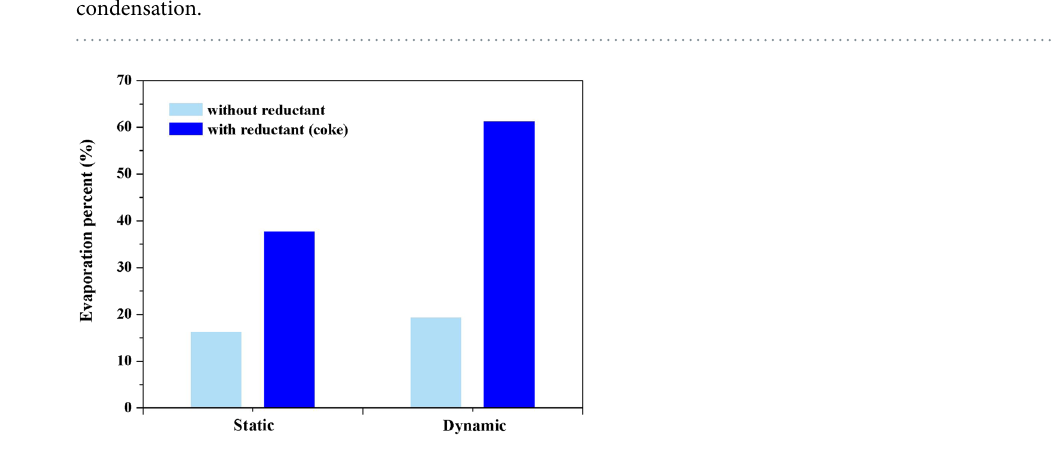
Figure 3. Comparison of dynamic state and static state of vacuum flash